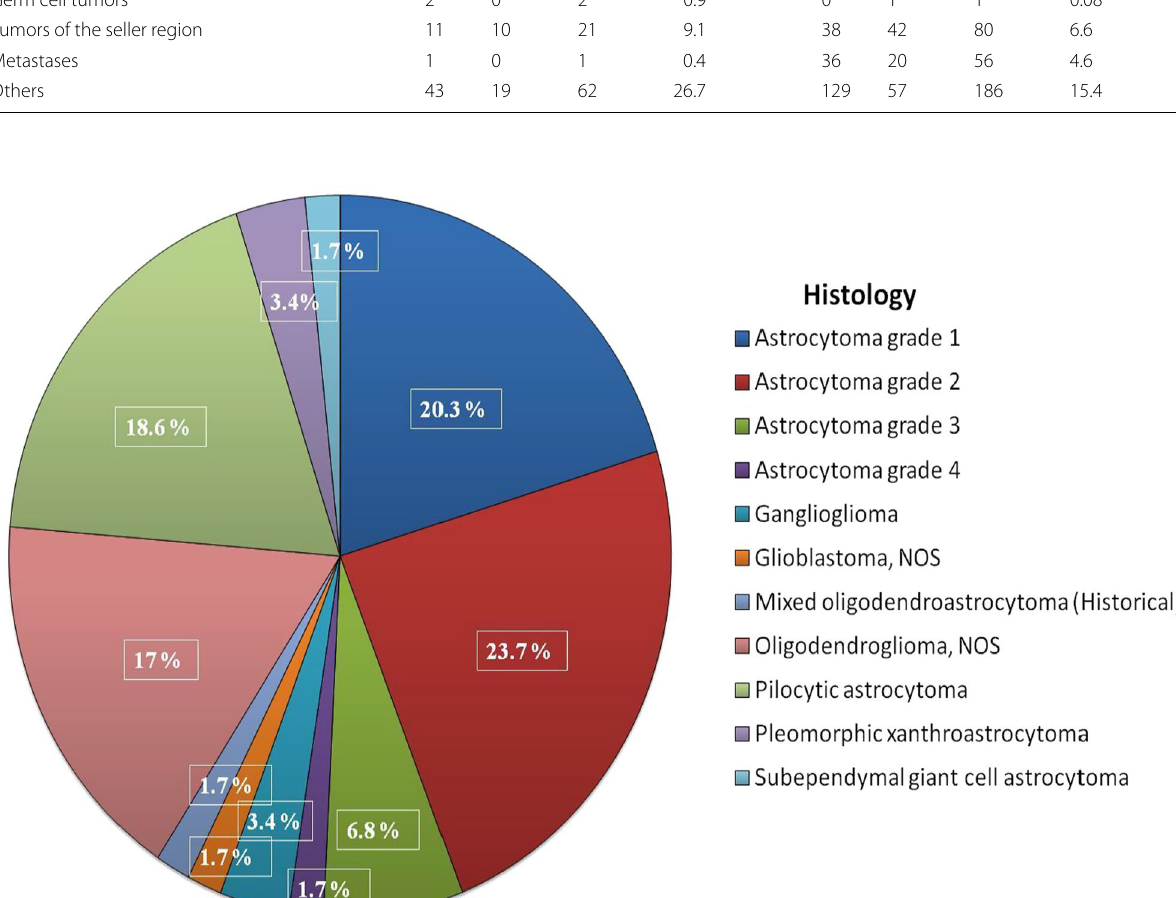
trocytoma (3.4%), and subependymal giant cell astro- cytoma (1.7%) were the other gliomas seen within the